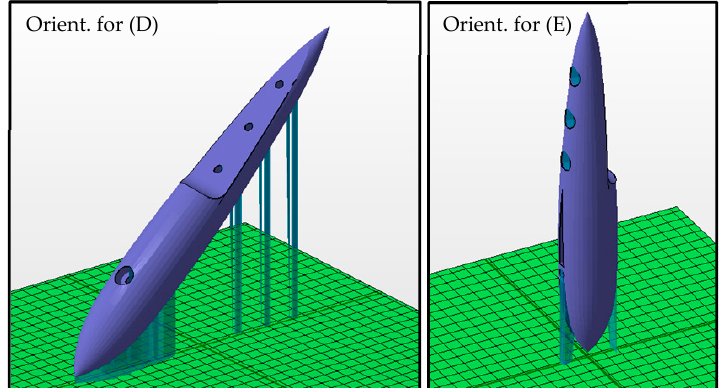
Figure 8. Run (D,E) with printing orientation emulation in order to account for support free core (overhang critical angle 45). In light blue, the support structures are shown. The overall longitudinal length of the component is 290 mm .